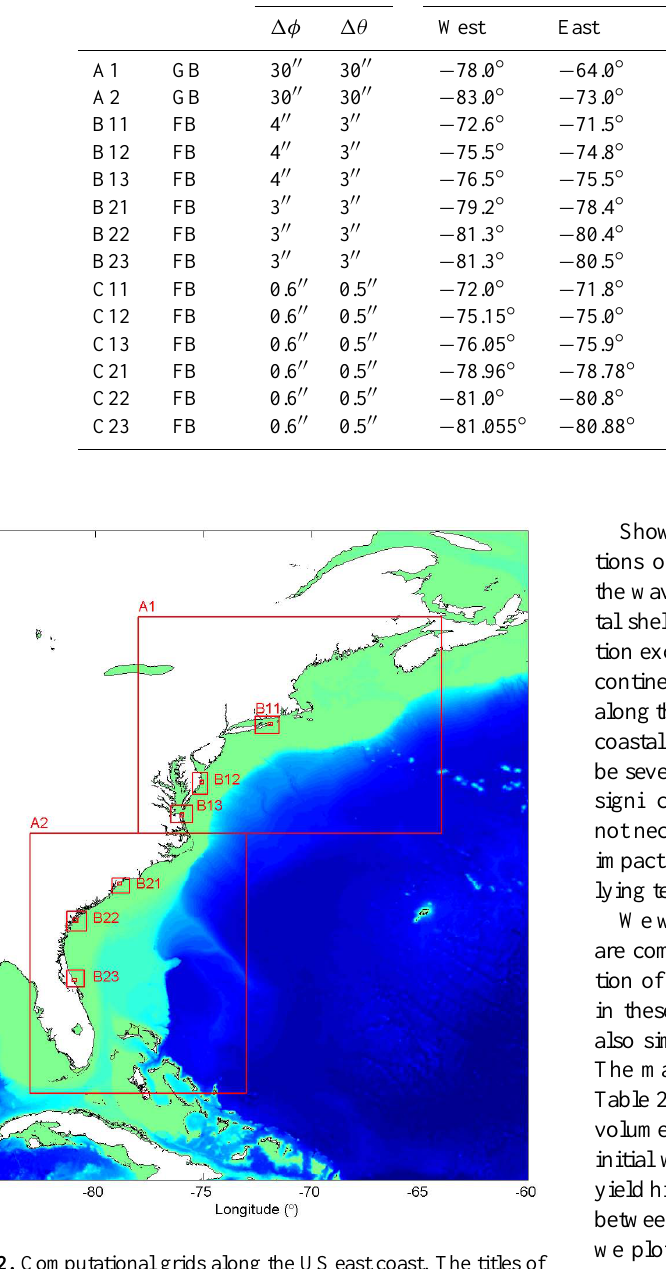
Fig. 22. A constant Manning’s roughness coefficient of